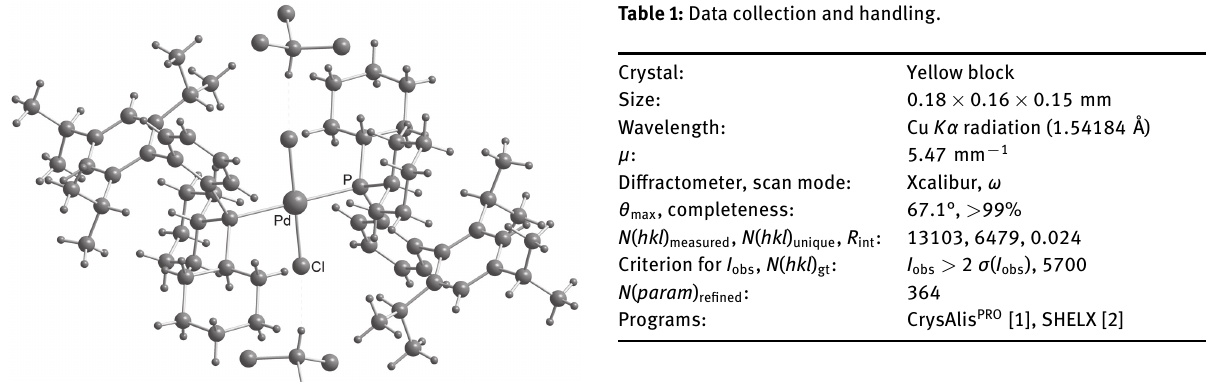
Table 2: Fractional atomic coordinates and isotropic or